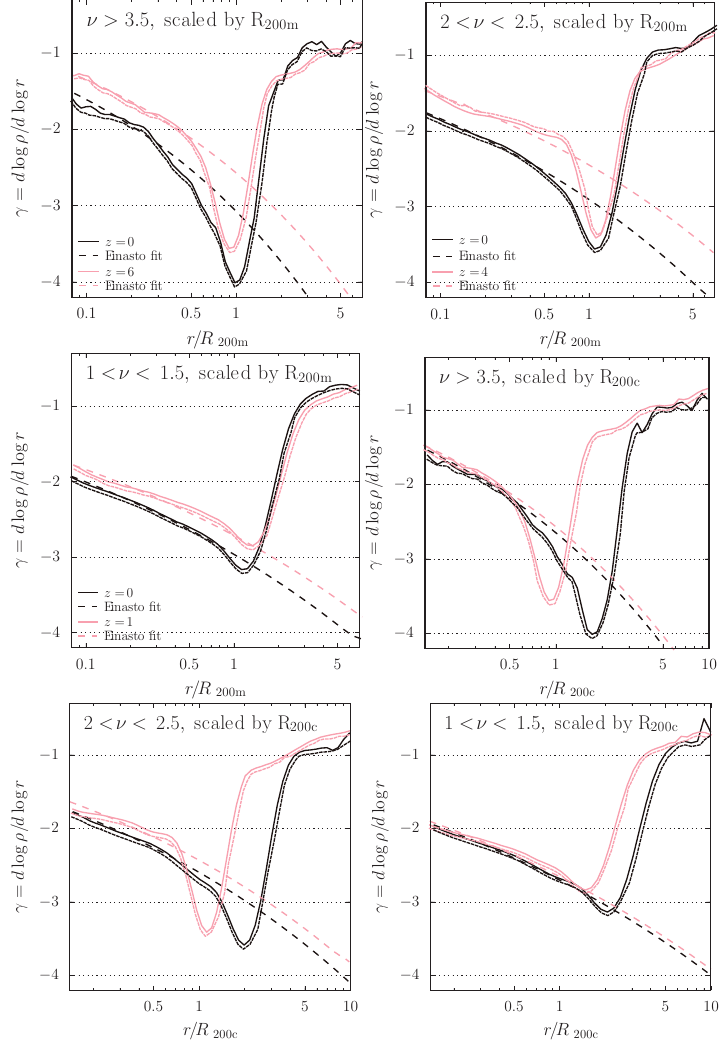
Figure 3. Logarithmic slope of three ν bins at different redshifts. The left panels are related to the ν > 3.5 sample of Figure 2. The central, and right panels refer to the ν bins shown in [19], Figure 5. The radii in the top panels are rescaled in units of R 200m , while those in the bottom panel are expressed in units of R 200c . Again, the solid lines stand for the simulations in [19], the dashed lines provide fits using the Einasto profile, and the dotted lines represents the result of our model. The black and red lines correspond to different redshifts indicated in the legends of the top